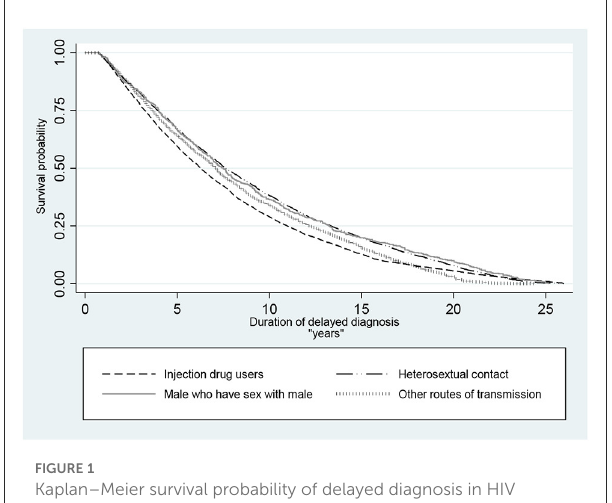
FIGURE1 Kaplan–Meier survival probability of delayed diagnosis in HIV patients in Iran ( P < 0.001 of log-rank test for equality of survivor